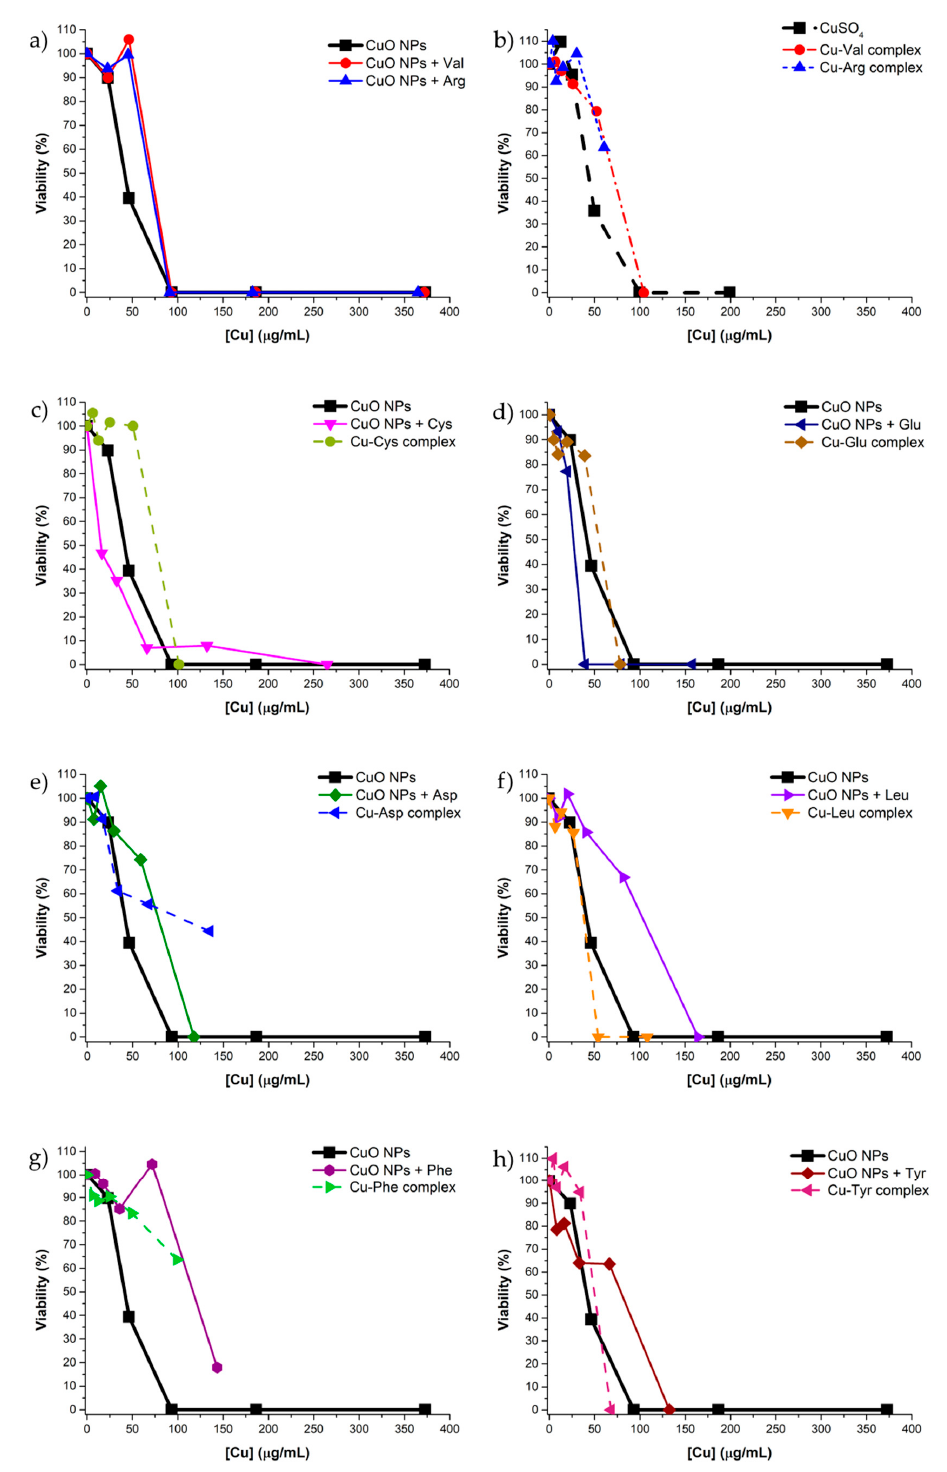
Figure 4. Viability (%) of the Gram-positive bacterium Staphylococcus epidermidis ATCC 35984 vs. copper concentration in ( a ) pristine CuO NPs, CuO NPs treated with Val and CuO NPs treated Arg; ( b ) CuSO4, Cu-Val complex and Cu-Arg complex; ( c ) pristine CuO NPs, CuO NPs treated with Cys and Cu-Cys complex; ( d ) pristine CuO NPs, CuO NPs treated with Glu and Cu-Glu complex; ( e ) pristine CuO NPs, CuO NPs treated with Asp and Cu-Asp complex; ( f ) pristine CuO NPs, CuO NPs treated with Leu and Cu-Leu complex; ( g ) pristine CuO NPs, CuO NPs treated with Phe and Cu-Phe complex and ( h ) pristine CuO NPs, CuO NPs treated with Tyr and Cu-Try